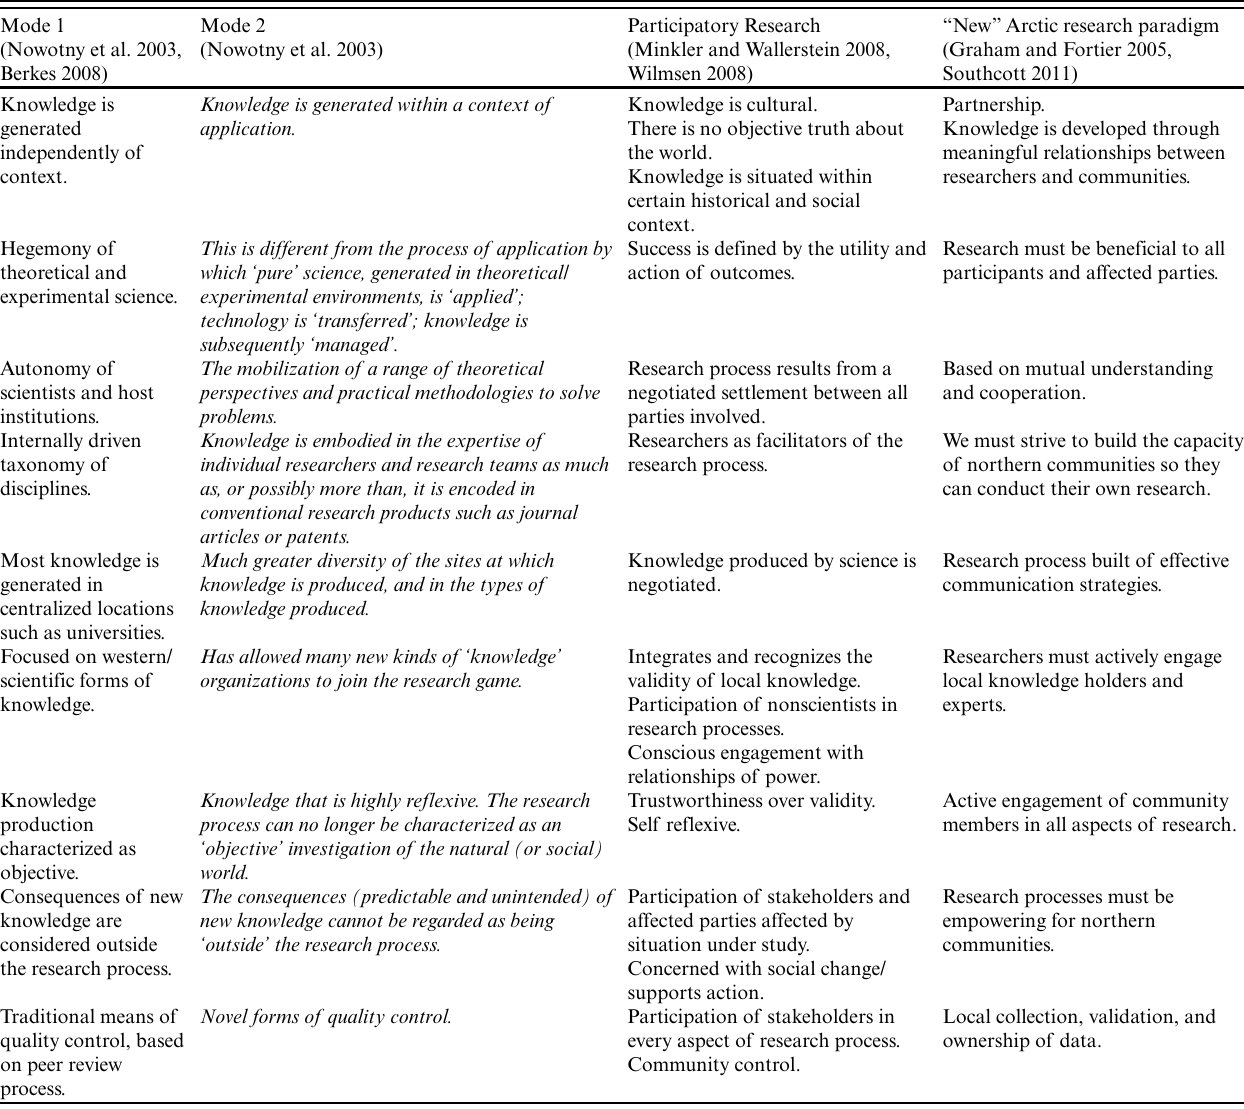
Table 1 . Comparative review of Mode 1, Mode 2, participatory research, and the new northern research paradigm. Italics are direct quotes from Nowotny et al.